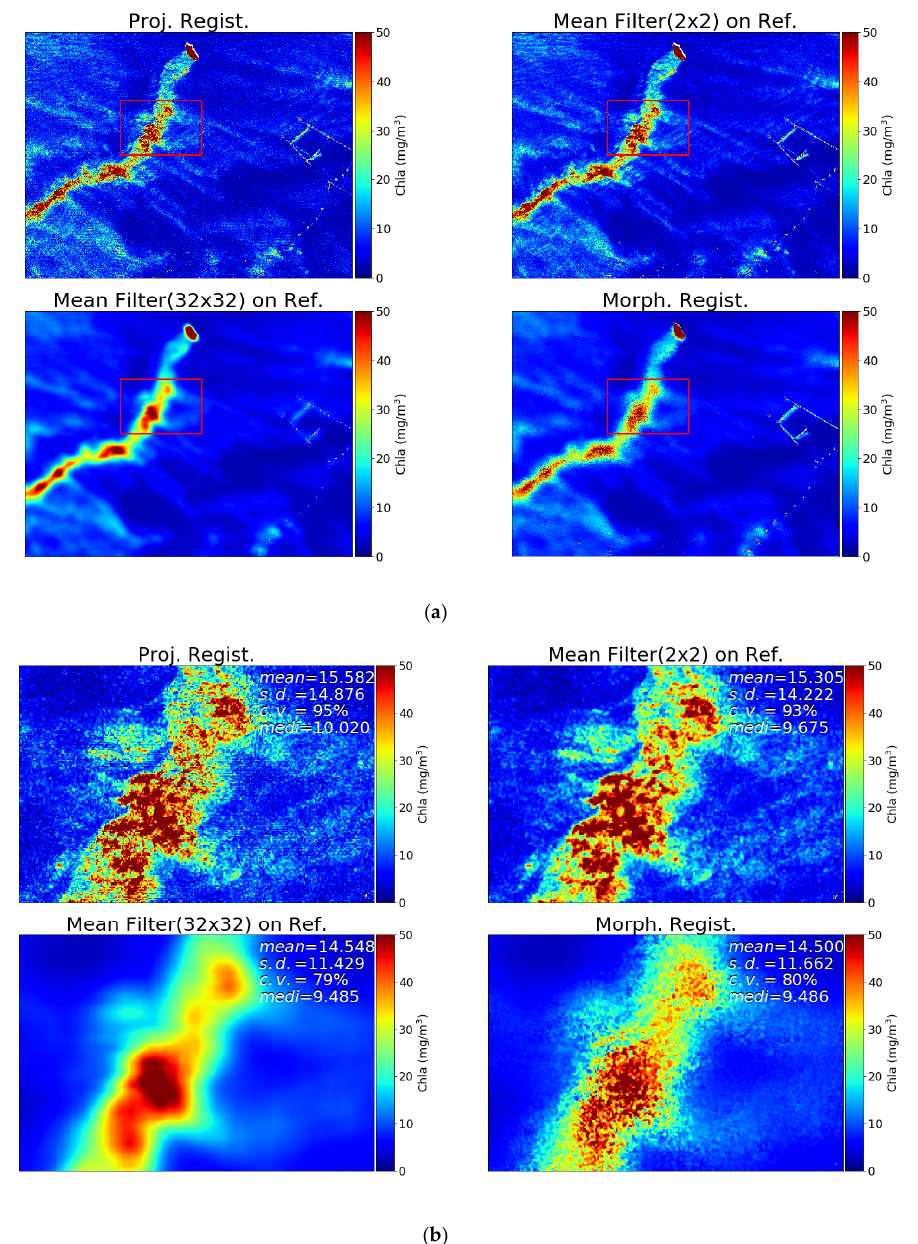
Figure 17. Scene-D acquired on 2019.08.31 at an altitude of 390 m. ( a ) Chla estimates from four di ff erent processings of R rs data; ( upper left ) before morphological registration, ( upper right ) after 2 × 2 mean filter on water reflectance, ( bottom left ) after 32 × 32 mean filter on water reflectance, and ( bottom right ) after morphological registration. ( b ) Close-up figures for the subset area marked in a red box in panel ( a ).